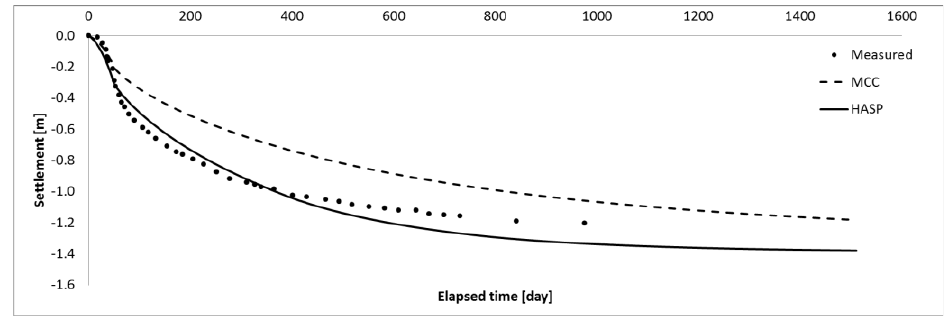
Figure 8. Comparison of settlement-time curves for Embankment A — Point 𝑆 0 (surface).